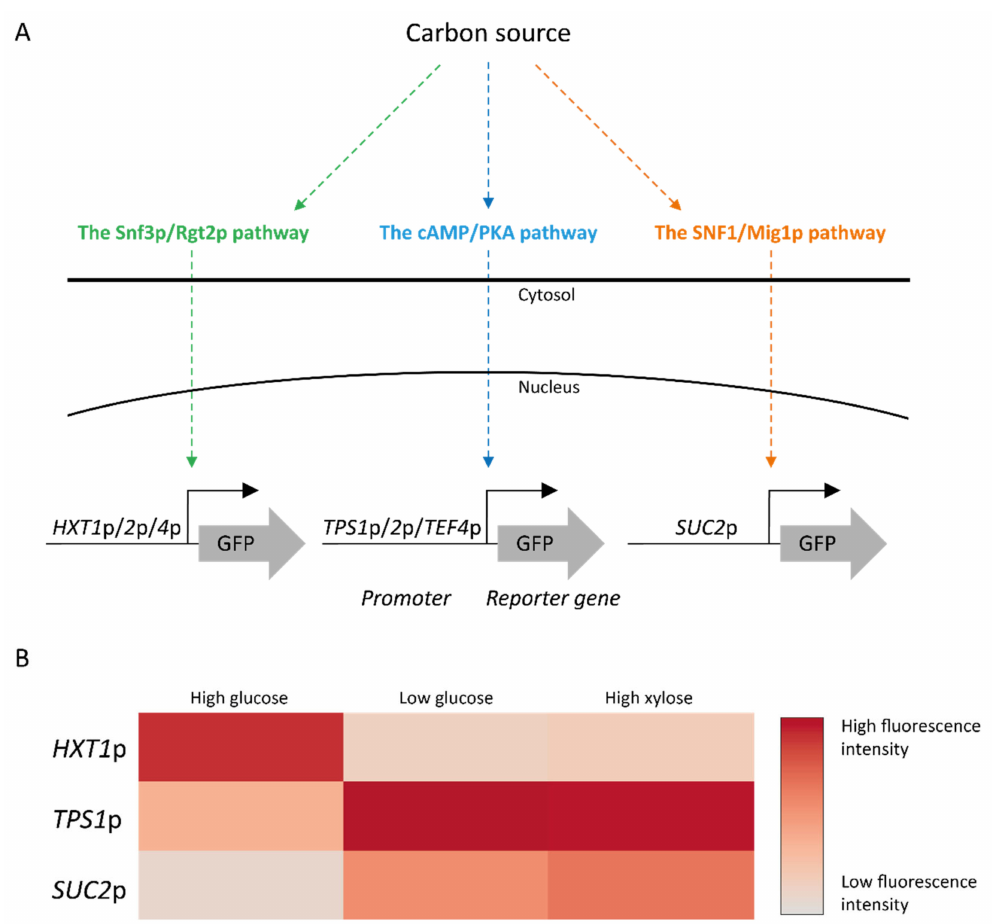
Figure 5. Schematic view of the biosensors constructed by Brink et al. [194] and the comparison of the effect of high D -glucose, low D -glucose and high D -xylose condition in the biosensors (heat map). ( A ). Fluorescent biosensors were constructed to assay the transcriptional effect of the three main sugar signaling pathways in the presence of D -xylose or D -glucose by coupling the promoters of signaling pathway target genes with a green fluorescent protein (GFP). ( B ). By following and quantifying the fluorescence intensity of the biosensor strains over time with flow cytometry, the known repression and induction conditions of the chosen promoters during presence of D -glucose were confirmed [107,224–226] and subsequently used to analyze the response to D -xylose in XR/XDH engineering strains